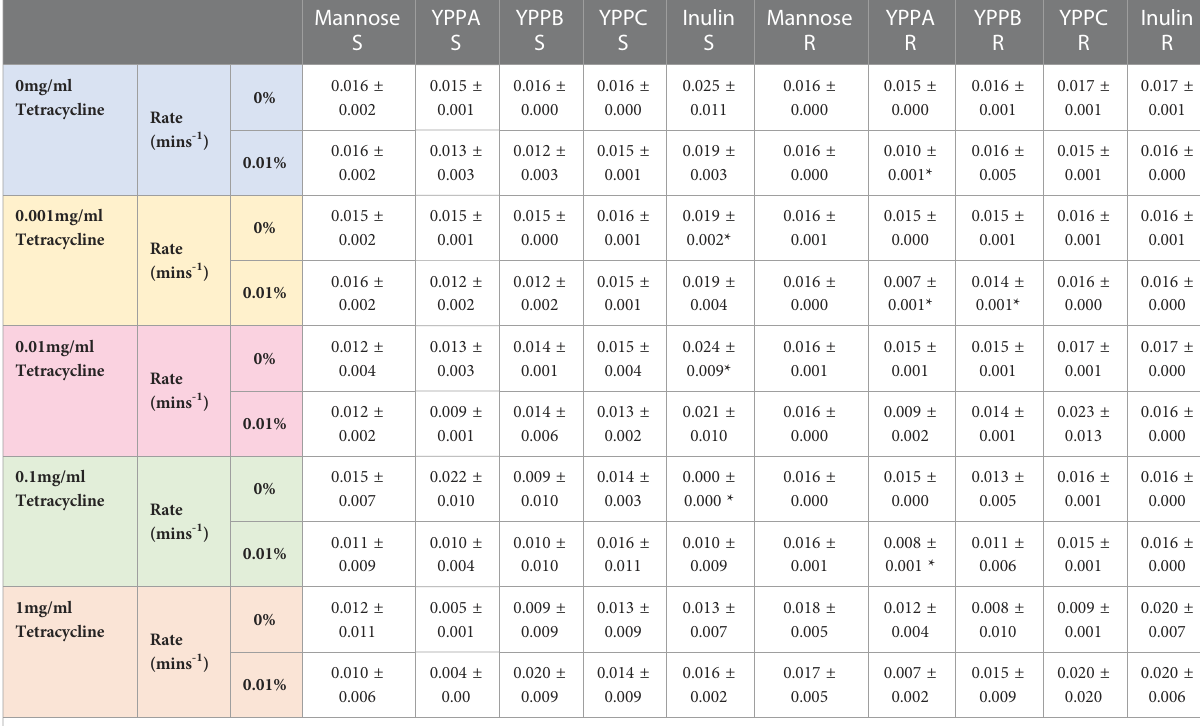
TABLE 1 Data represents the average growth rate (n=3) for susceptible (S) and resistant (R) E. coli treated with 0mg/ml-1mg/ml tetracycline in combination with either 0% w/v or 0.01% w/v yeast product